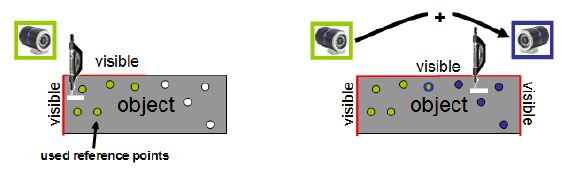
Figure 14: Dynamic referencing to increase measurement volume .